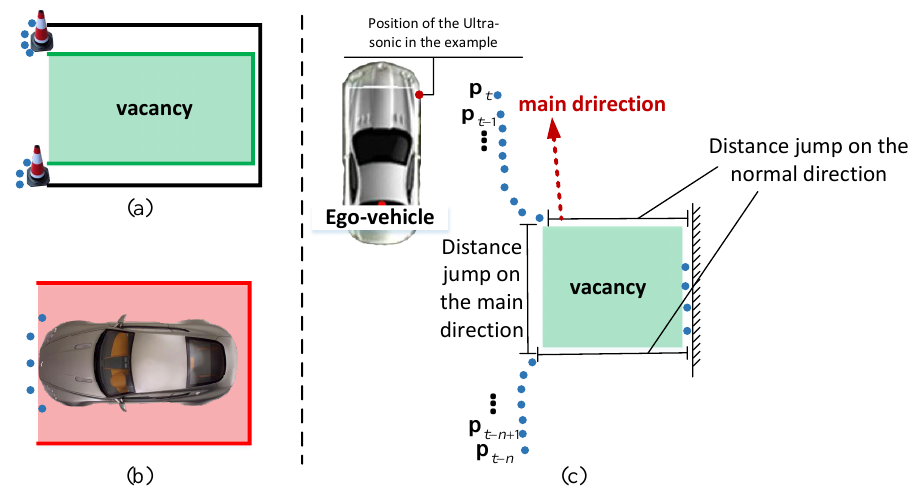
Figure 10. Parkable detection with an ultra-sonic sensor. In ( a ), the black box is the vision detecting result. By fusion with sonic data, the parkable area shrinks to the green area. In ( b ), the parking area detected by the camera has a car parking in it. Therefore, the result needs to be abandoned. In ( c ), vacancy area is obtained by taking the example of the right-front sensor. The blue points are the historical points obtained by the right-front sensor integrated over